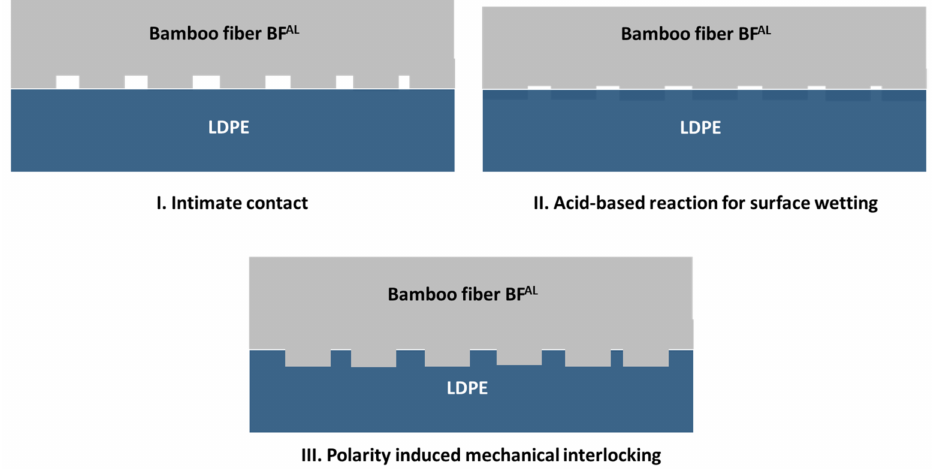
Figure 4. Fiber-matrix interfacial bonding mechanism: ( I ) intimate contact, ( II ) acid-based reaction and surface wetting, ( III ) polarity-induced mechanical